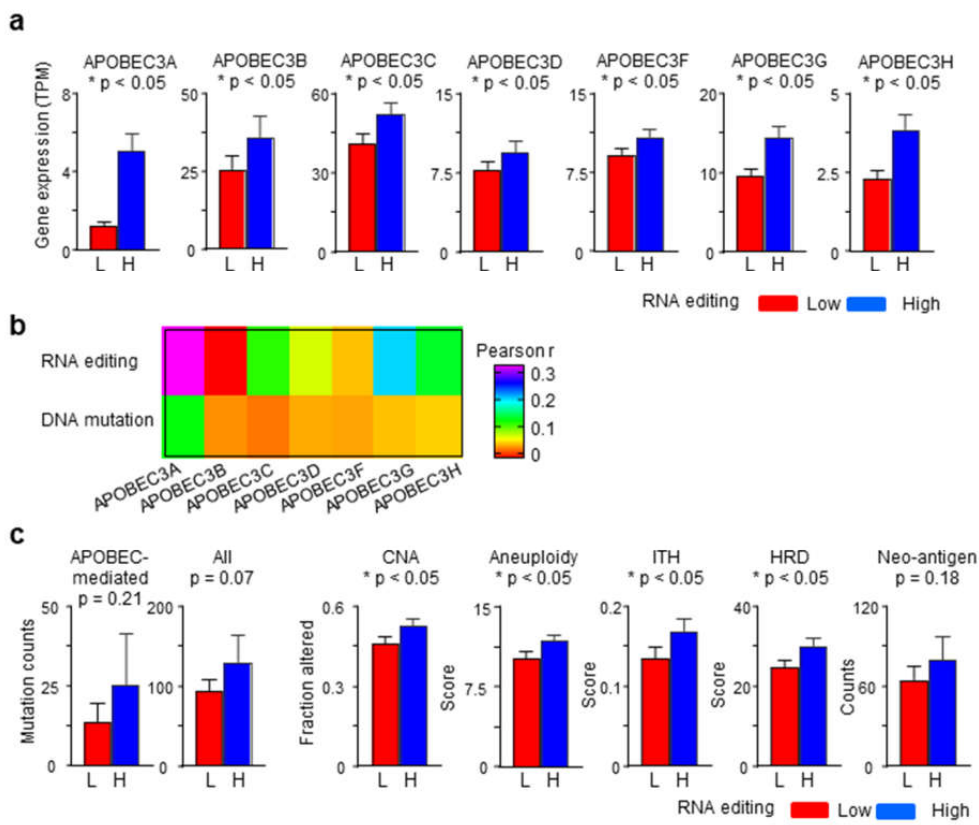
Figure 3. RNA editing and APOBEC3 gene expression and genome characteristics of tumors. ( a ) Tukey boxplots show APOBEC3 gene expression of RNA editing-high (H) and -low (L) tumors. TPM, transcripts per million. ( b ) Heatmap shows Pearson′s correlation coefficients for association of APOBEC3 gene expression levels with APOBEC3-mediated C-to-U RNA editing score and APOBEC signature DNA mutation burden of tumors. ( c ) Barplots are shown for comparison of tumor genome characteristics of the RNA editing-high and -low tumors. p -values in two-group comparisons were calculated with Fisher’s exact or standard t -tests. CNA, copy number alteration; HRD, homologous recombination deficiency; ITH, intra-tumor heterogeneity; SNV, single nucleotide